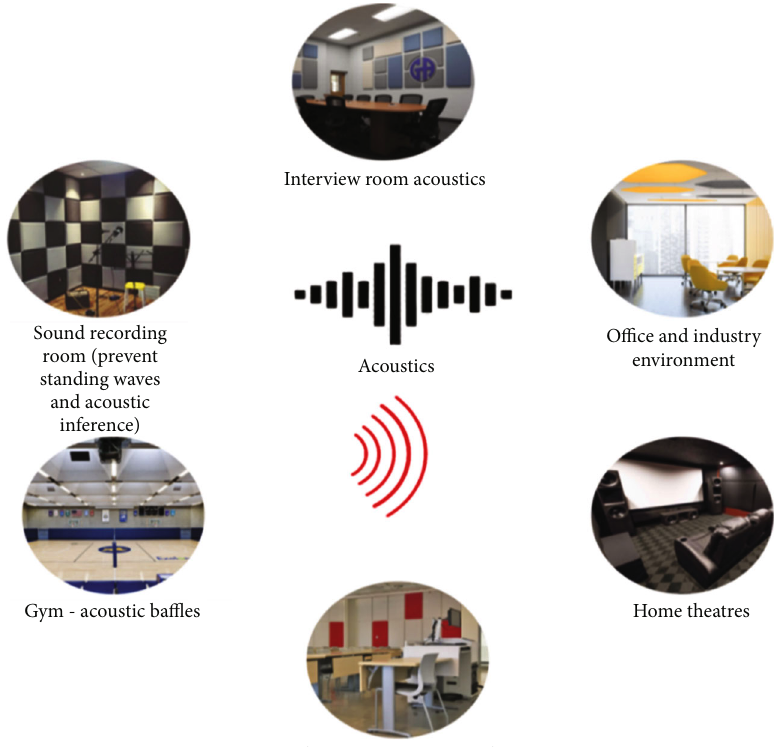
Figure 7: Application of natural fi bre in soundproo fi ng.